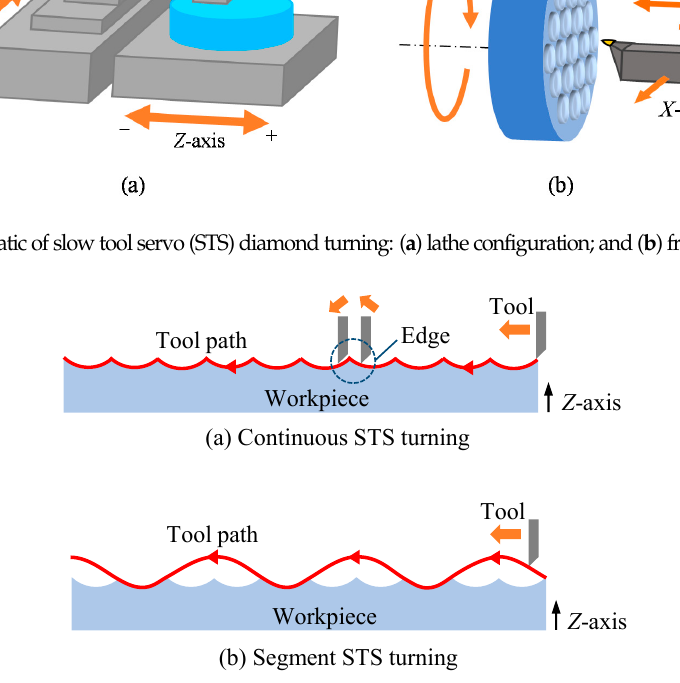
Figure 2. Schematics of tool paths for two STS turning methods to generate a microlens array.